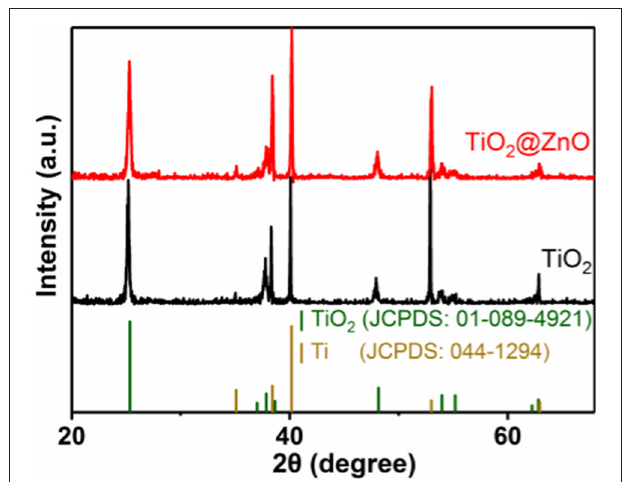
FIGURE 1 | X-ray diffraction (XRD) patterns of pristine TiO 2 and TiO 2 @ZnO